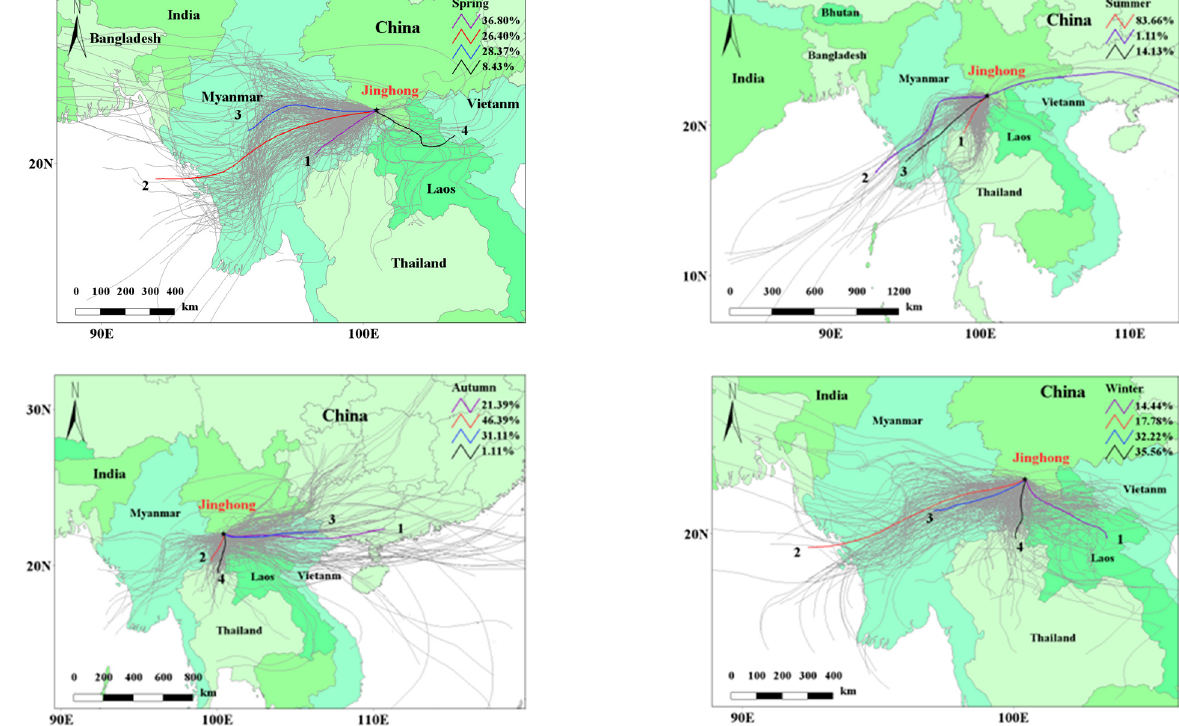
Figure 4. Backward clustering on a four-season backward trajectory in Jinghong in 2020. Table 6. Clustering results of four-season backward trajectories in Jinghong in 2020 and the accom- panying average concentrations of pollutants.